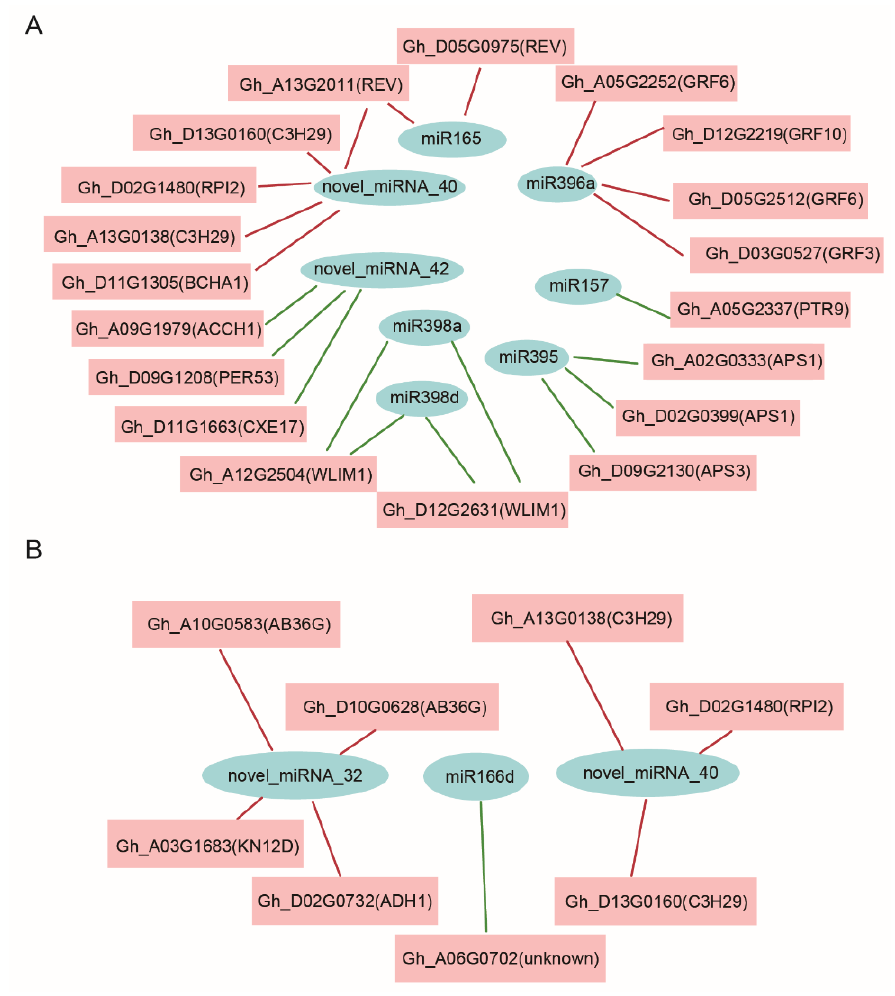
Figure 5. Regulatory network between miRNAs and target mRNAs associated with V. dahliae stress in J11 ( A ) and Z2 ( B ). Red lines represent downregulated miRNAs and upregulated mRNA pairs, green lines represent upregulated miRNAs and downregulated mRNA pairs.